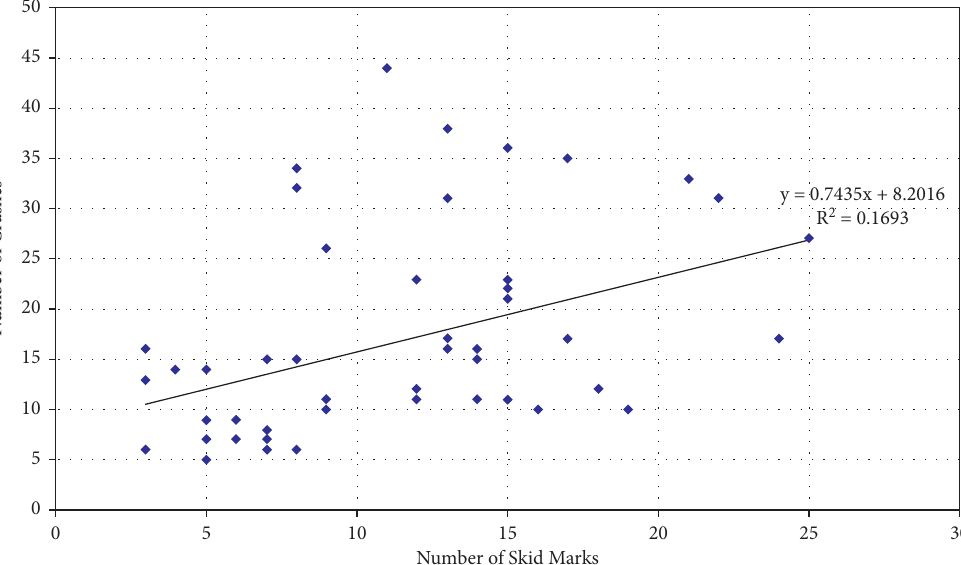
Figure 13: Sliding windows crash vs. skid correlation on Interstate 80 westbound (1.0-mile windows, 0.20-mile